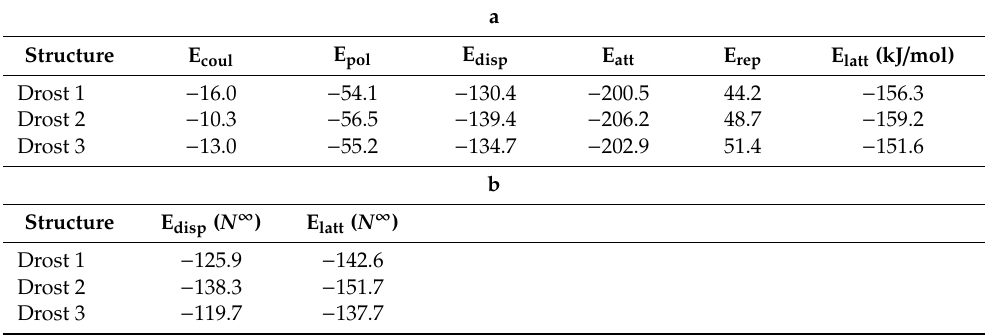
Table 5. a. CLP energy components (E coul —Coulombic, E pol —polarization, E disp —dispersion, E att